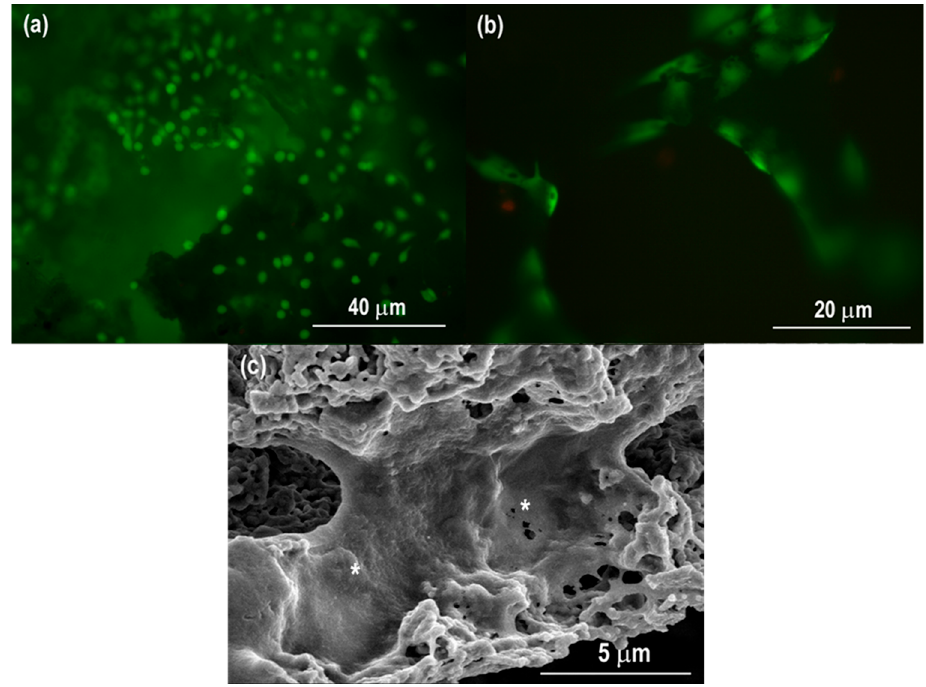
Figure 7. Fluorescence images from the Live/Dead® assay (viable cells stain green; dead cells stain red) on ( a ) the edge and ( b ) in the center of the porous HHA scaffold disc. ( c ) SEM image of Saos-2 osteoblast-like cells on the HHA scaffold after culturing for 7 days. * Cells apparent on the wall of the HHA scaffold.